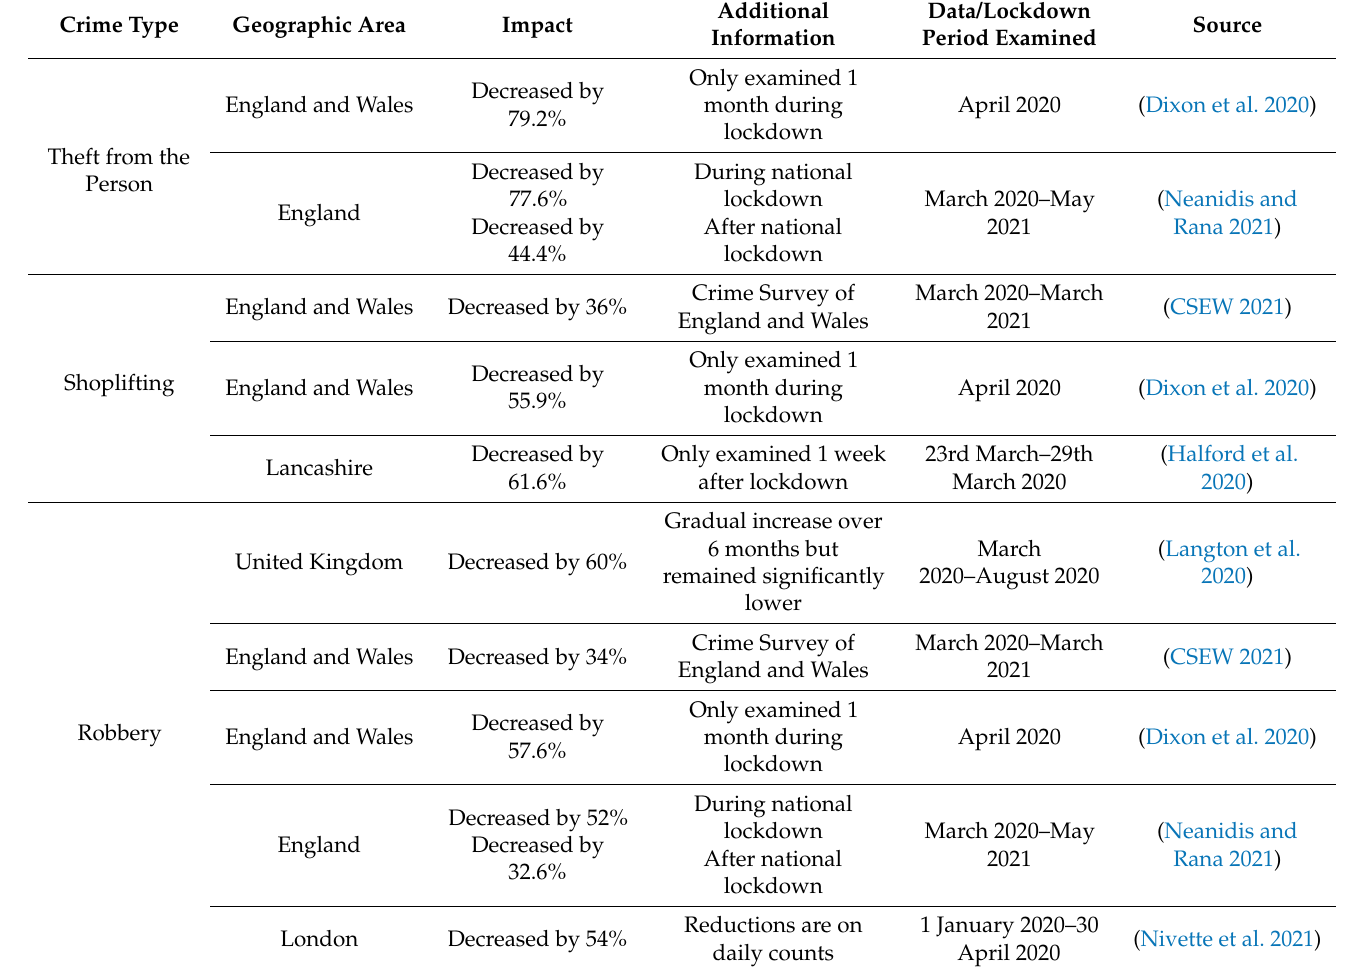
Table A1. Percentile Impact Identified from Studies of the Impact of COVID-19 on UK Police Reactive Demand (Recorded Crime and